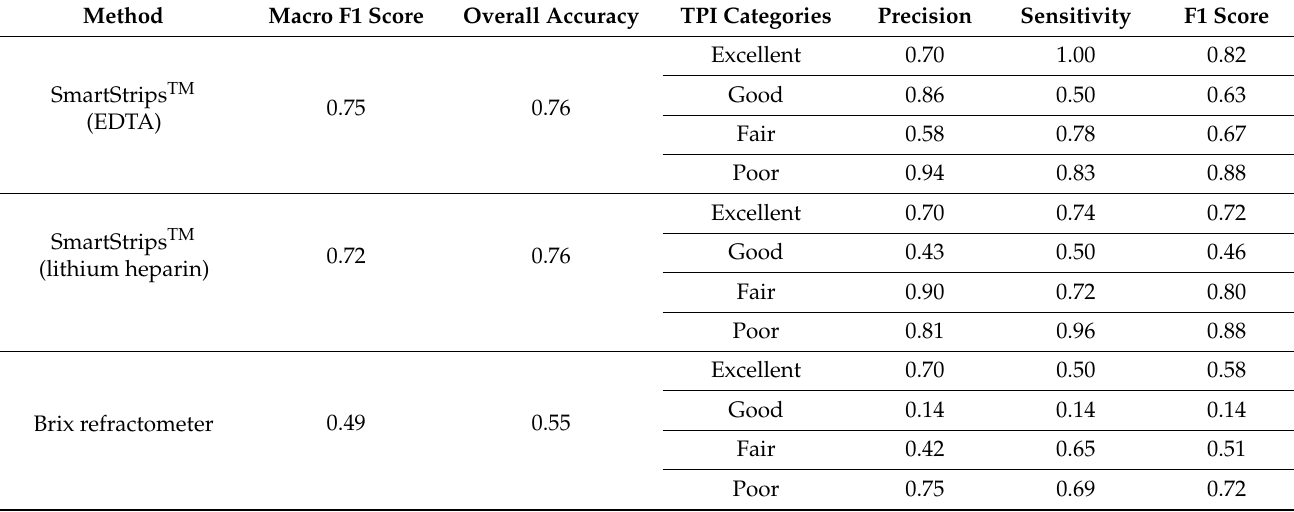
Table 3. Diagnostic test characteristics (4 categories of transfer of passive immunity (TPI)) for the SmartStrips TM quick tests (with EDTA or lithium heparin anticoagulant) and the Brix refractometer compared to ELISA ( n = 97 for all methods). See Table 1 for the definition of the categories.